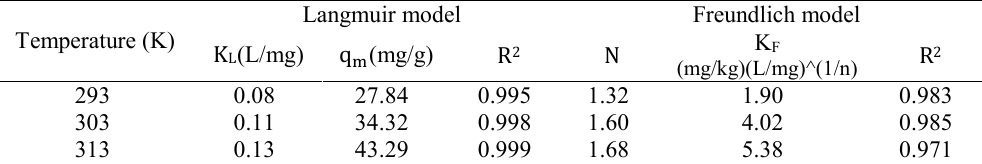
Table 2. Isotherm parameters for the adsorption of cobalt on magnetite-citric acid adsorbent